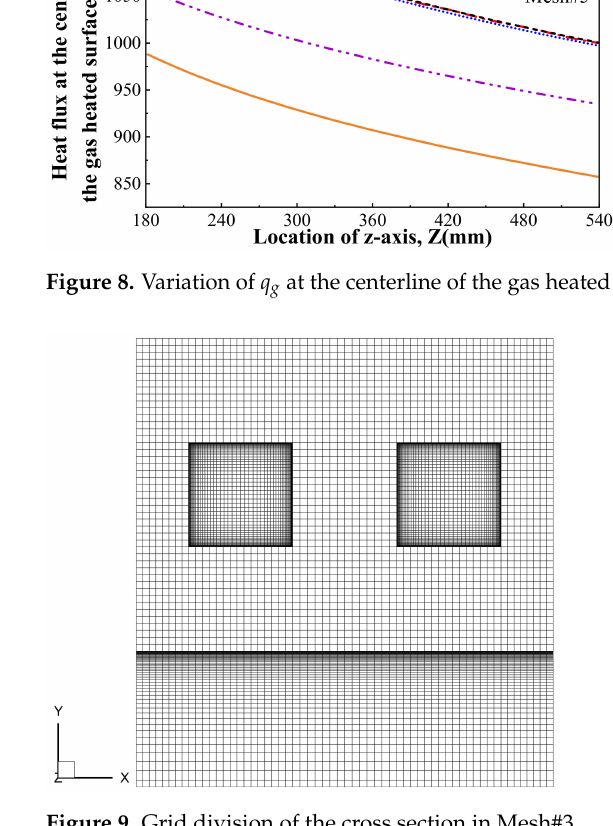
Figure 9. Grid division of the cross section in